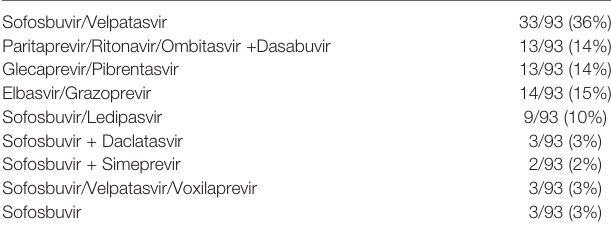
TABLE 3 | DAA regimens used in the patient population.